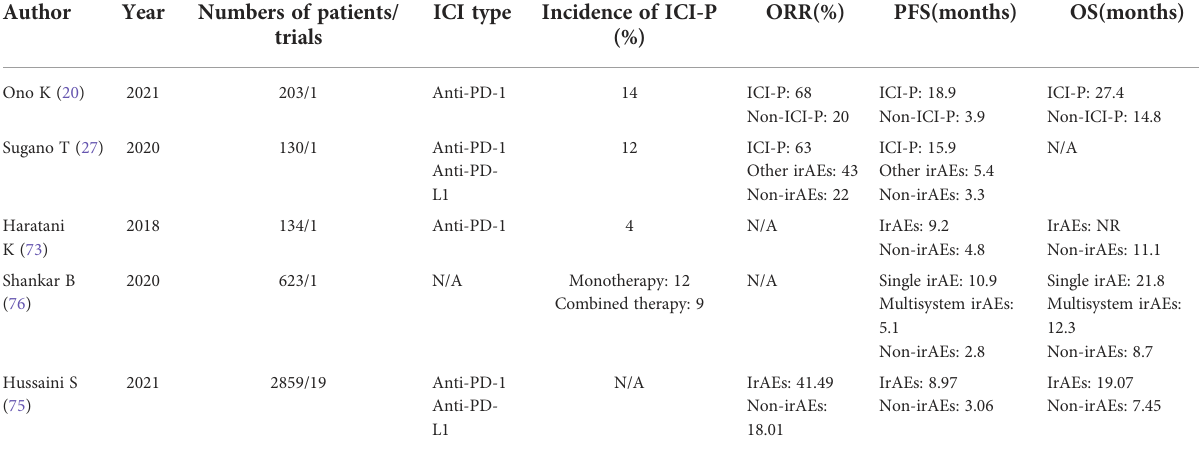
TABLE 5 Published researches on association between the occurrence of ICI-P and the outcome of immunotherapy in NSCLC.